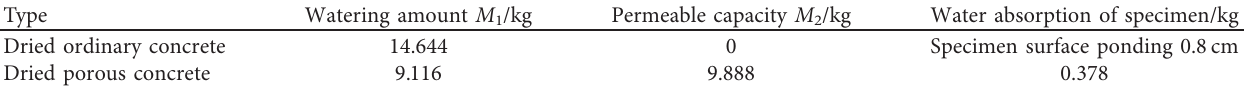
Table 3: Water retention of concrete.